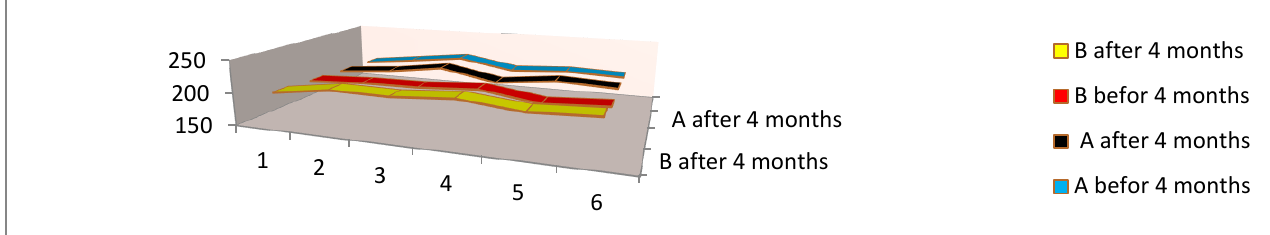
Fig. 3. Comparison of the two groups' mean TG (mg/dl) with time (baseline and after four